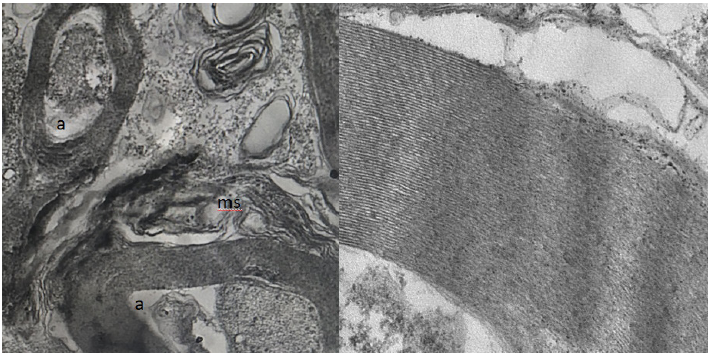
Fig. 3 - Electron microscopy examination of the spinal cord. The image on the left side shows a view of a subject from the I/R group. a: axonal/myelin separation and axoplasmic dissolution. ms: myelin separation. The image on the right side shows regular myelin sequences in the electron microscope view of a subject in the group that received